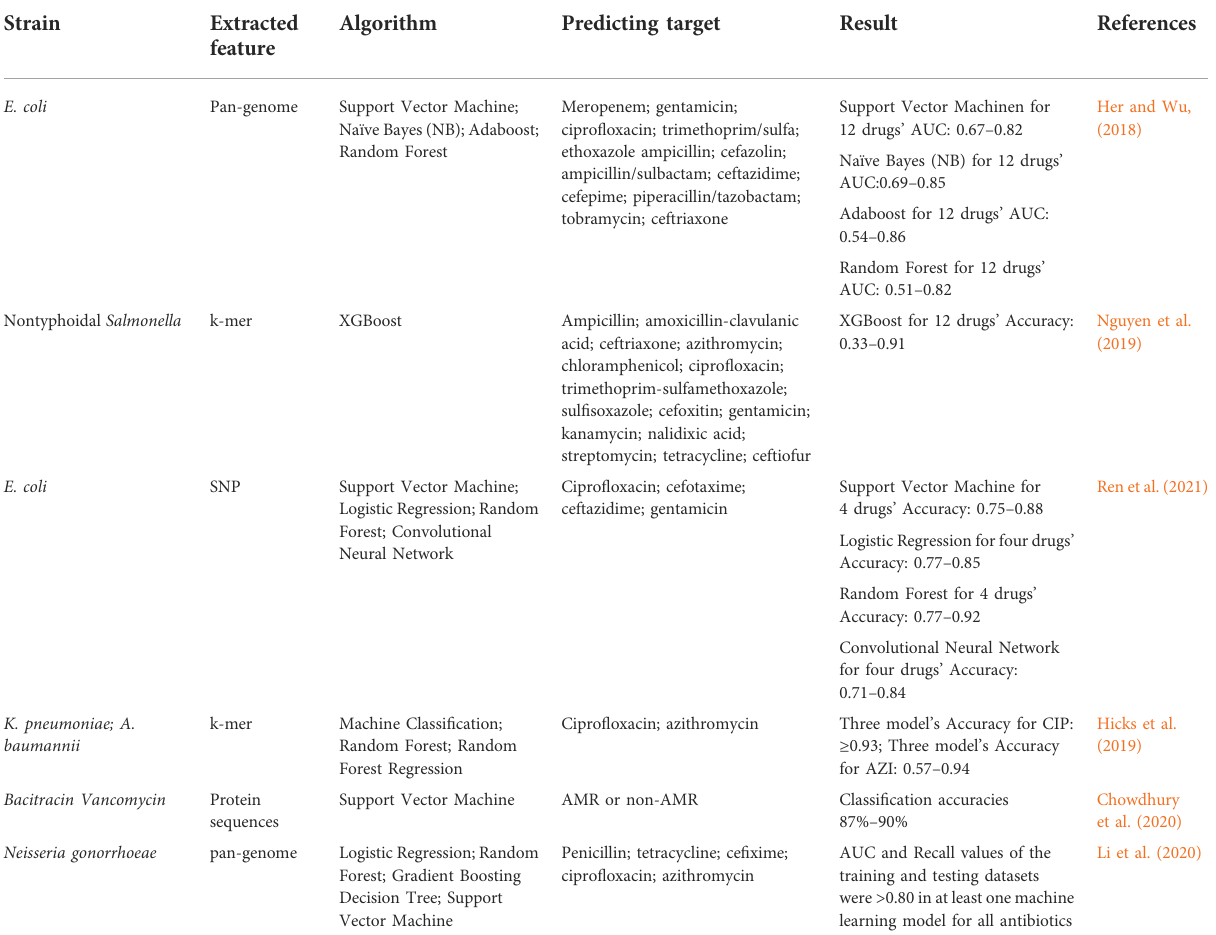
TABLE 3 Recent progresses on ML for AMR